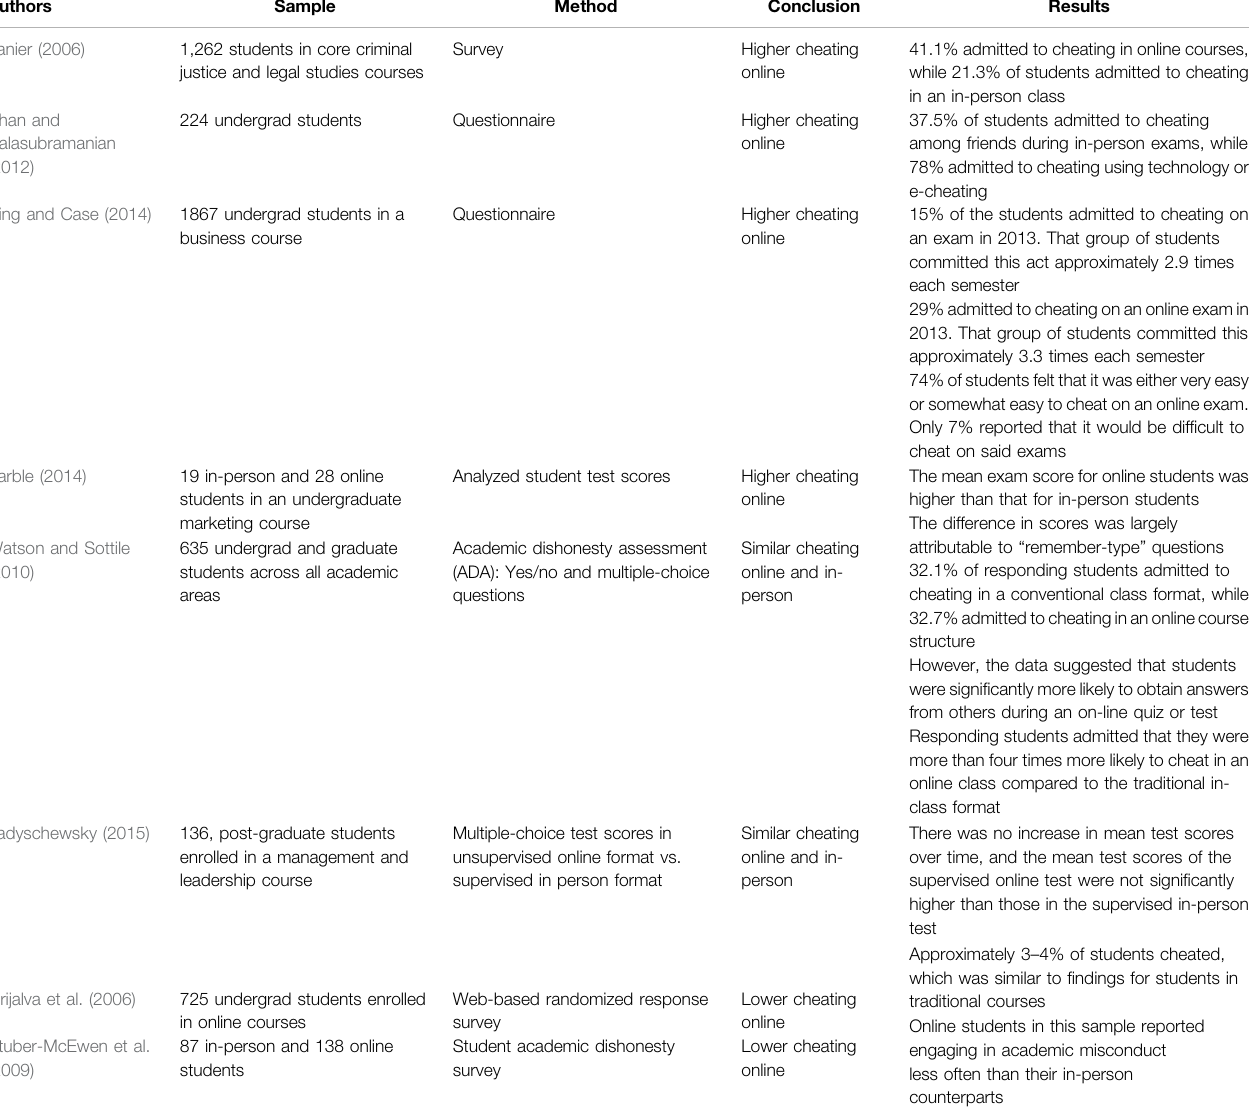
TABLE 1 | Studies Comparing Academic Dishonesty in Online Classes and In-Person Classes .